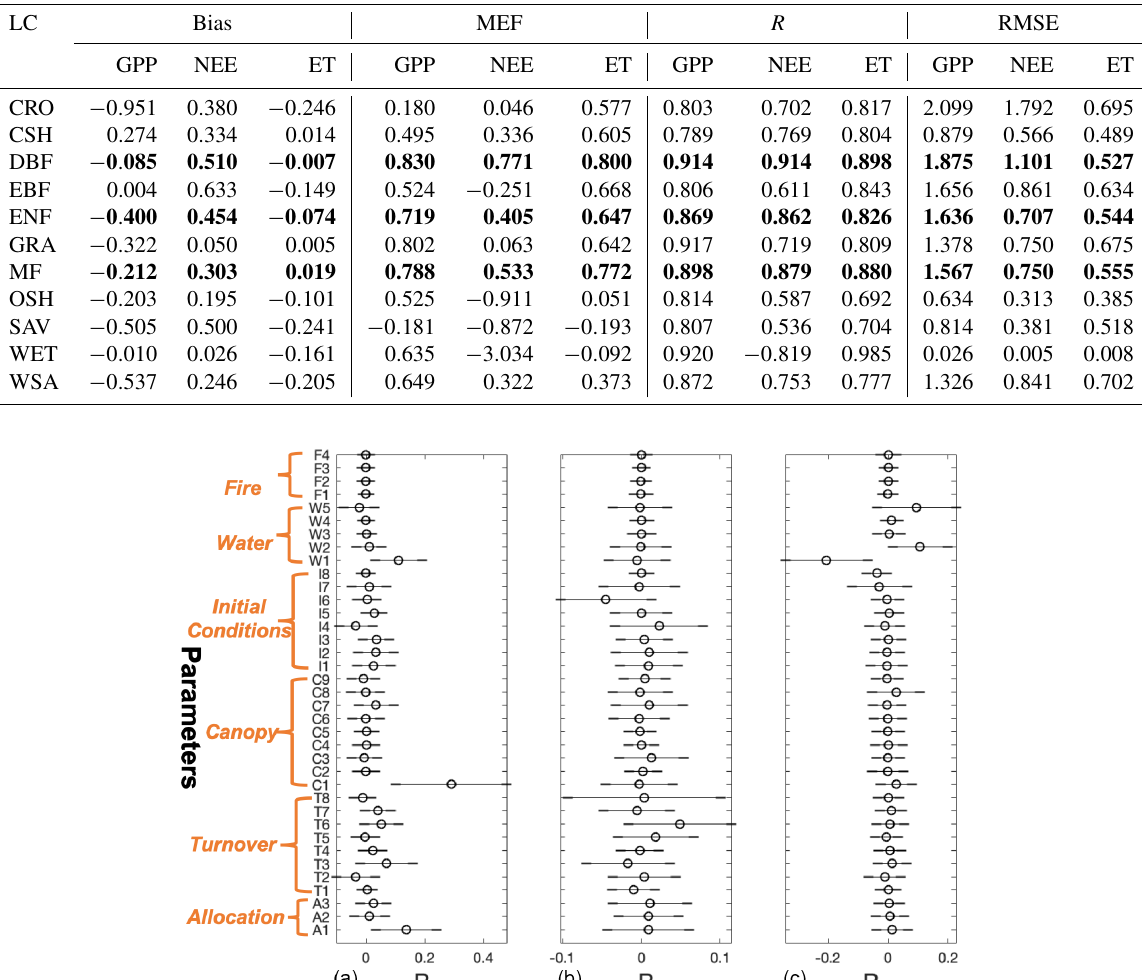
Table 4. The bias, MEF, R , and RMSE of GPP (unit: gCm − 2 d − 1 ), NEE (unit: gCm − 2 d − 1 ), and ET (unit: mmd − 1 ) assimilation versus the flux tower data for different land-cover types. Text in bold shows the land-cover types that have the most accurate predictions.